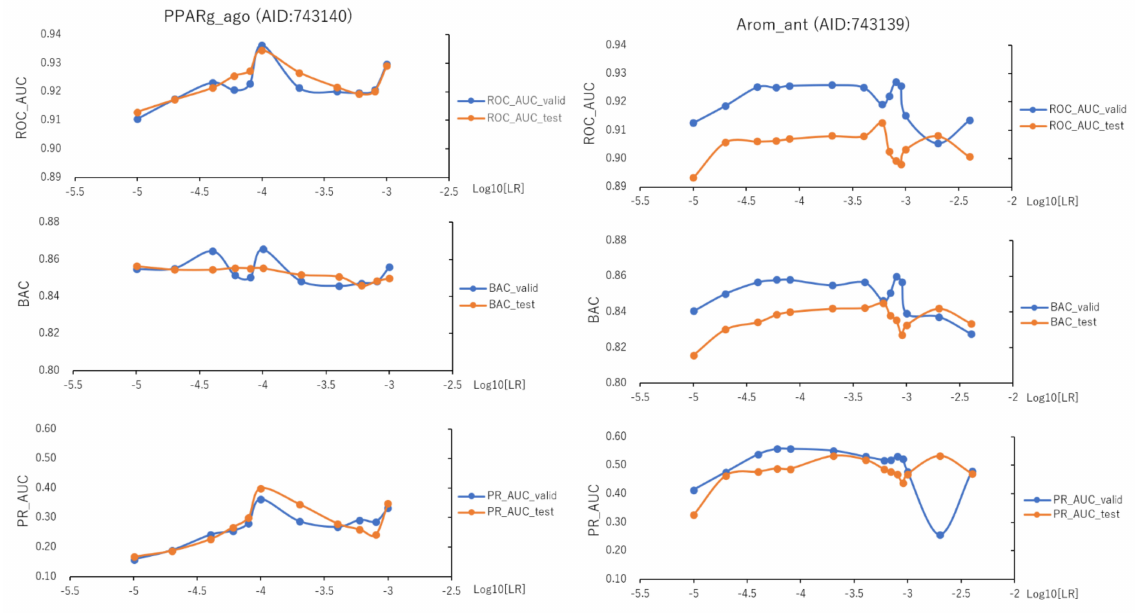
Figure 10. ROC_AUC, BAC, and PR_AUC for PPARg_ago (AID:743140) and Arom_ant (AID:743139) on the validation and test datasets using TensorFlow with different learning rates (LRs). Three-fold experiments were